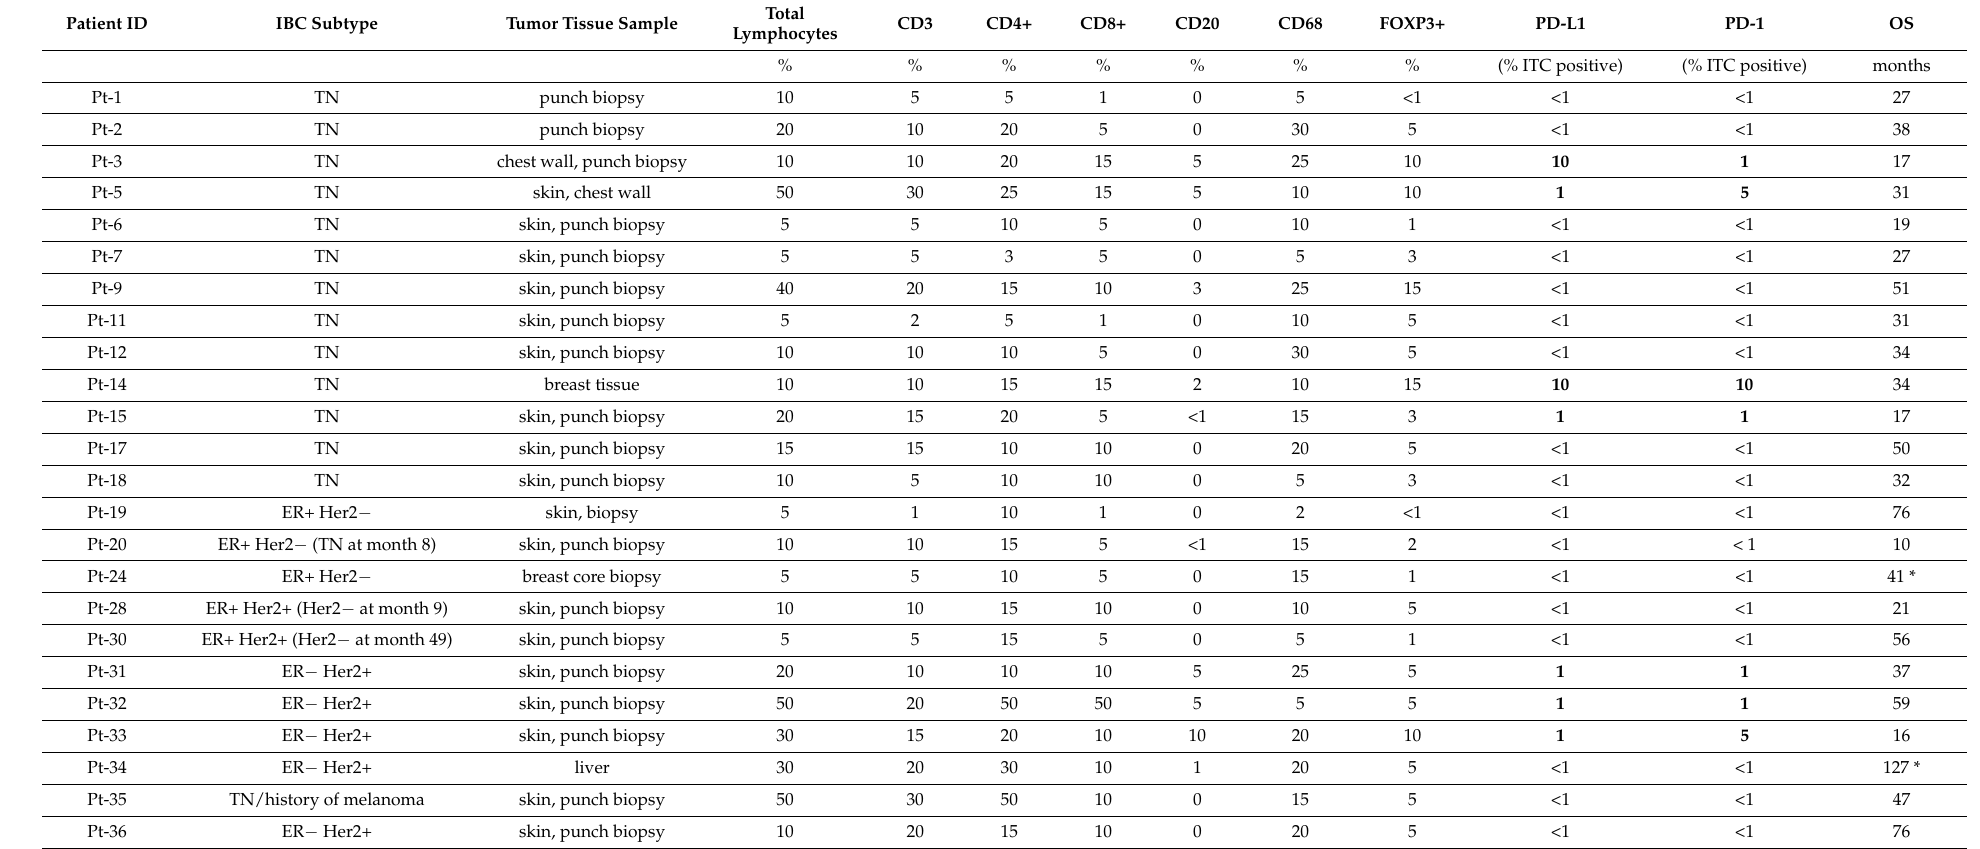
Table 2. Immune cell infiltrates, PD-1 and PD-L1 expression in tumor tissue biopsies of IBC patients. The tumor tissue samples were quantified for total T lymphocytes (CD3+), helper T cells (CD4+), cytotoxic T cells (CD8+), B cells (CD20+), macrophages (CD68+), and T regulatory cells (FoxP3+). For each analysis, evaluation was conducted in the tumor and immediately peri-tumoral areas with quantitation as a percentage of positive cells relative to total nucleated cells. Both PD-L1 and PD-1 were evaluated as the percentage area of positive staining within tumor-infiltrating lymphocytes (TILs). PD-L1 < 1% was considered negative and >1% was considered positive; same for PD-1. PD-L1 and PD-1 positive values are bold. Overall survival (OS) is indicated for each patient. In OS: * Last record available, patient